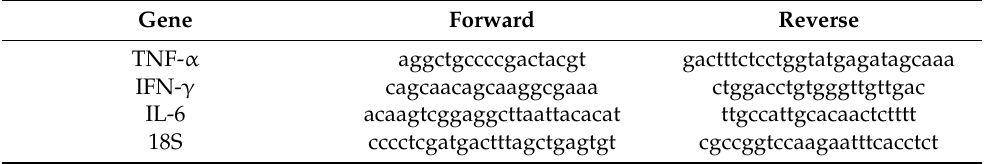
Table 1. Primer sequences designed to evaluate TNF-a, IFN-g, IL-6, and 18S (as control) mRNA by RT-PCR.